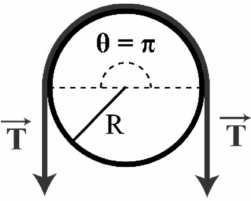
Figure 2. Principle of the bending behavior